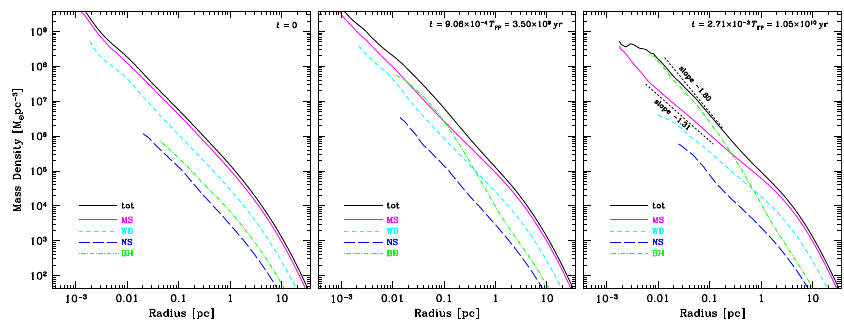
Fig. 22 Evolution of a multi-mass system corresponding to Sgr A*. The model contains stellar-mass black holes, with masses between 10and30 times larger than MS stars on average. On the left panel, we have the initial conditions, at t = 0 yr. When we leave the system evolve, the components separate and roughly after a Hubble time we obtain the situation corresponding to the right panel. Image reproduced with permission from Freitag et al. (2006b), copyright by